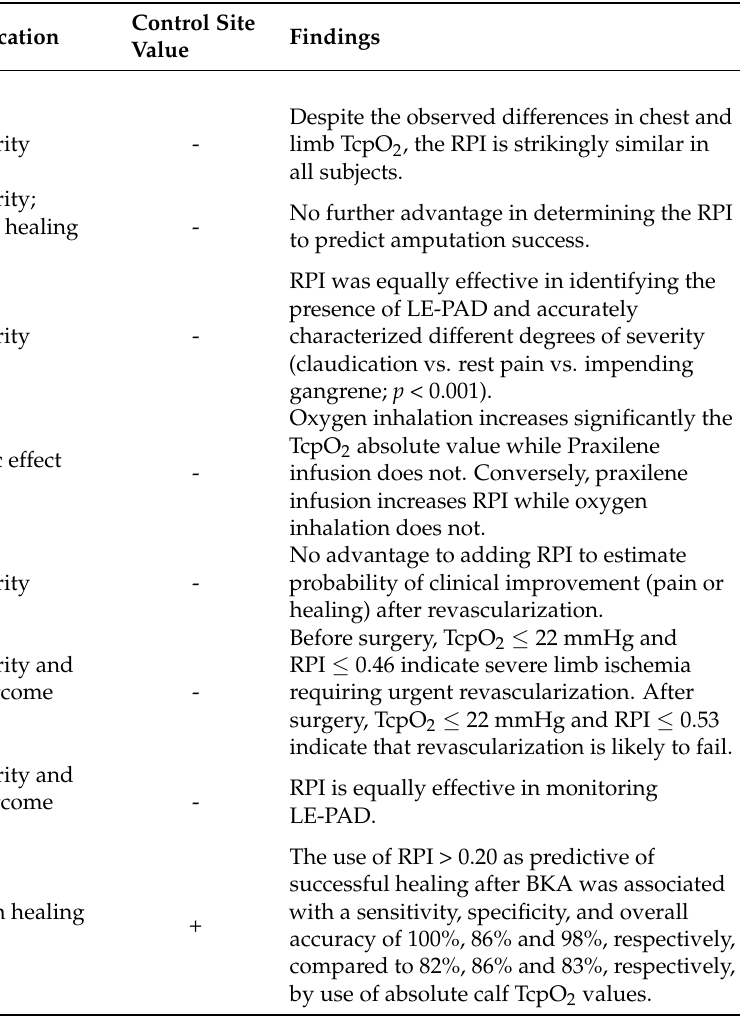
Table 1. Overview of included